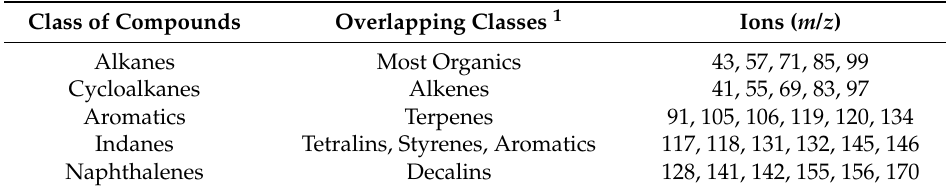
Table 3. List of characteristic ions which are summed and/or overlaid to generate EICs during examination of sample data for interpretation